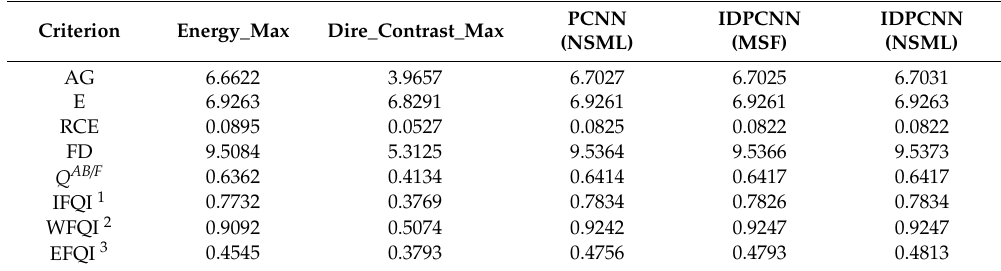
Table 3. Objective evaluation indexes of the fused aircraft debris image (Data 1).